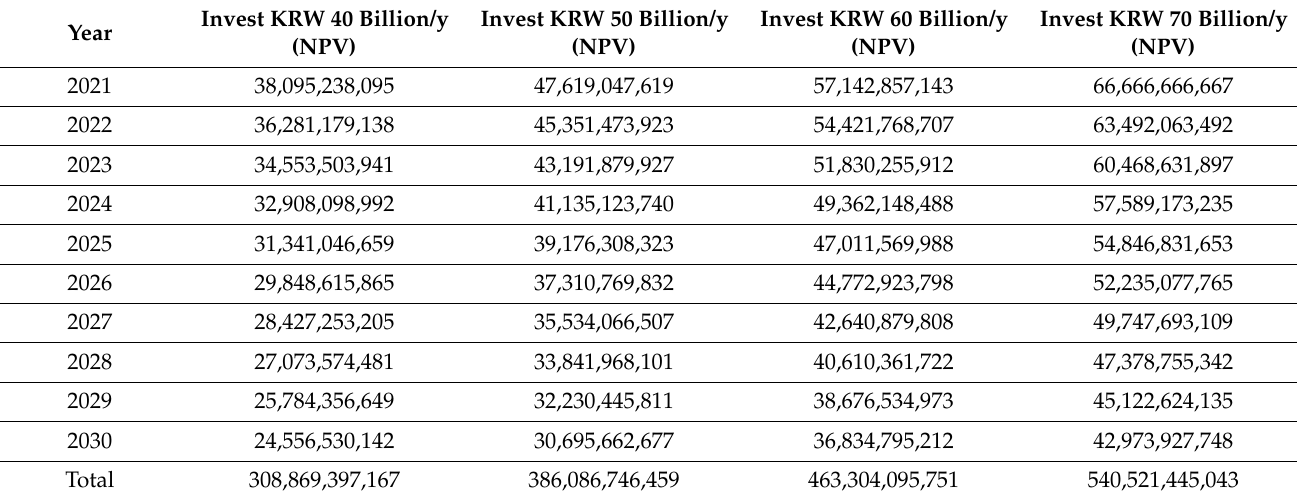
Table 10. Pyroprocessing cost (R&D investment cost; net present value (NPV); unit: